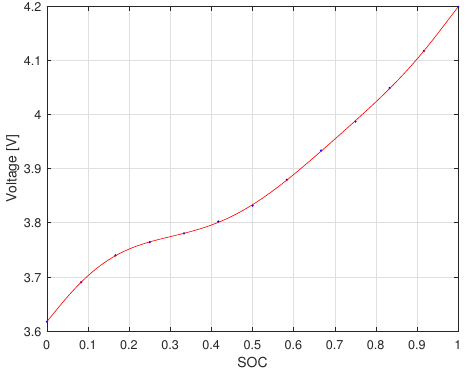
Figure 2. Nonlinear relationship of a battery state of charge and